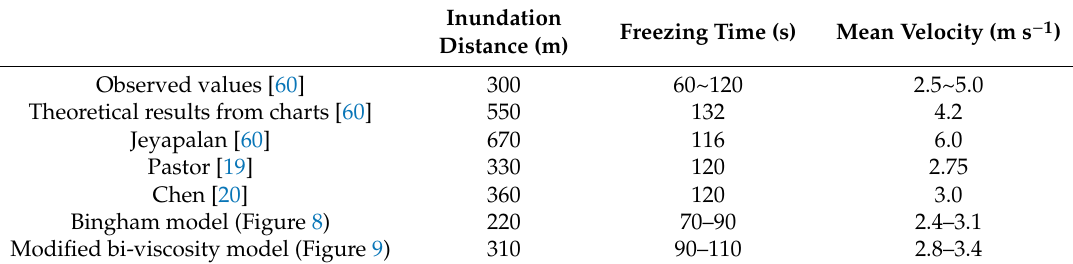
Table 1. The summary key values in the case of FGT66.